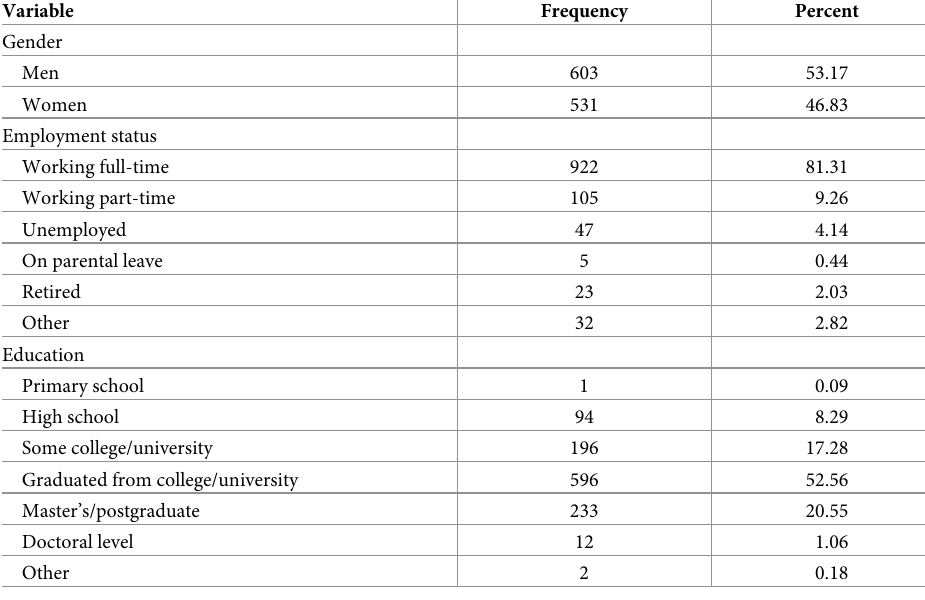
Table 1. Sociodemographic variables.